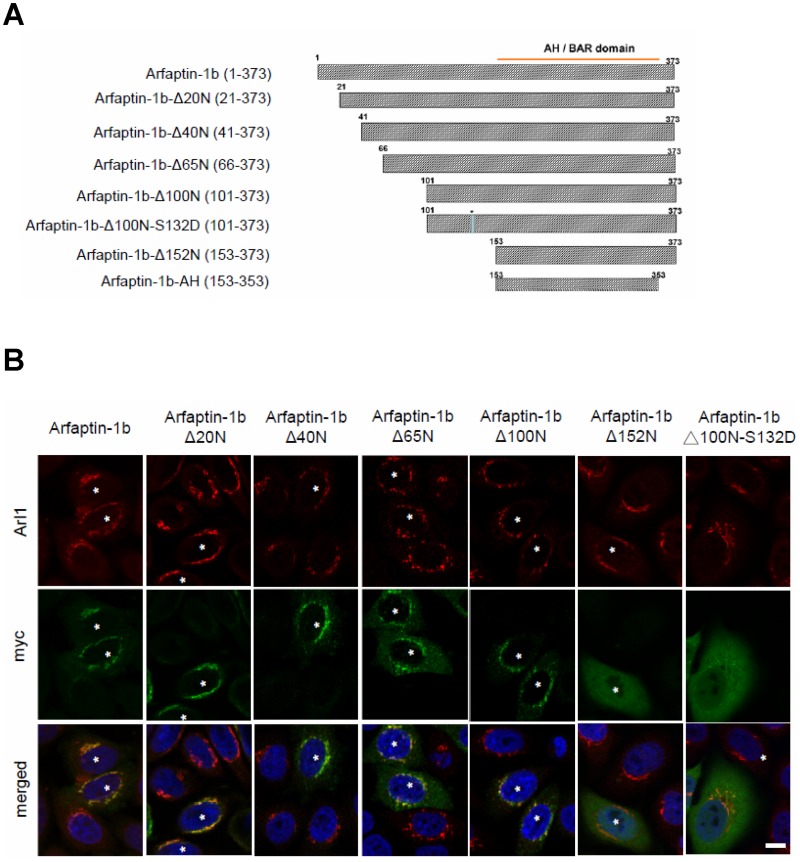
The N-terminal region of arfaptin-1 is required for localization to the Golgi.(A) Schematic showing the arfaptin-1 N-terminal truncations and mutations used in this study. (B) HeLa cells were transfected with wild-type or truncated arfaptin-1b-myc constructs for 48 h. The cells were then stained with anti-myc and anti-Arl1 antibodies. Scale bars, 10 μm. Asterisks indicate cells expressing truncated or mutated arfaptin-1-myc constructs.